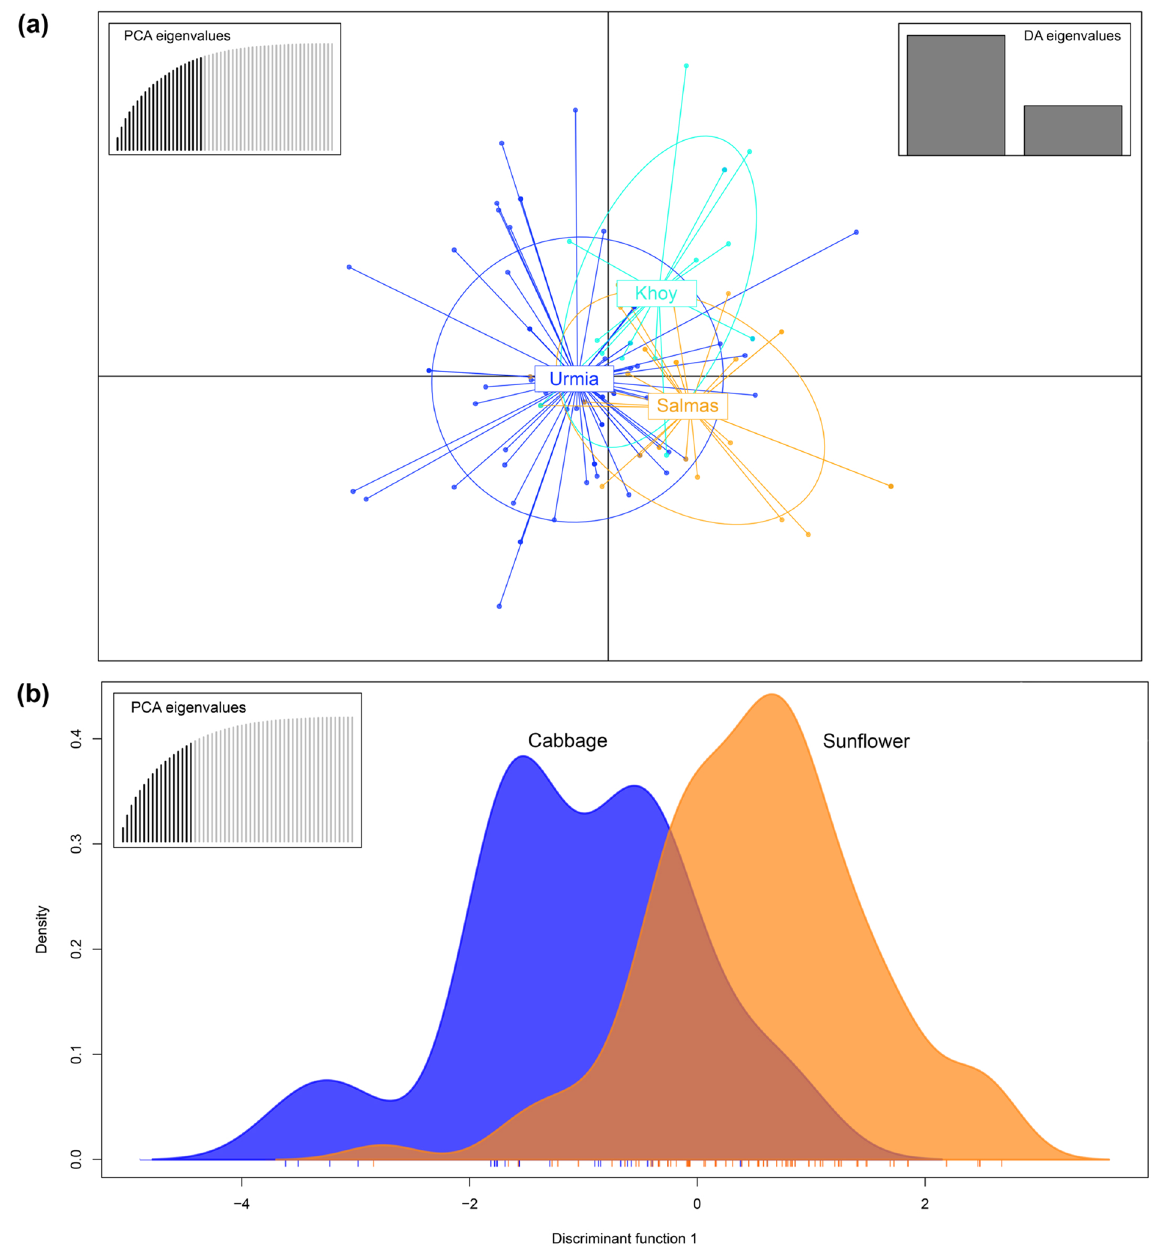
Figure 2. Scatter plot ( a ) and density plot on the first discriminant function ( b ) showing discriminant analysis of principal components (DAPC) for ISSR multilocus genotypes (MLGs) of Sclerotinia sclerotiorum from geographic and host populations, respectively. Dots represent